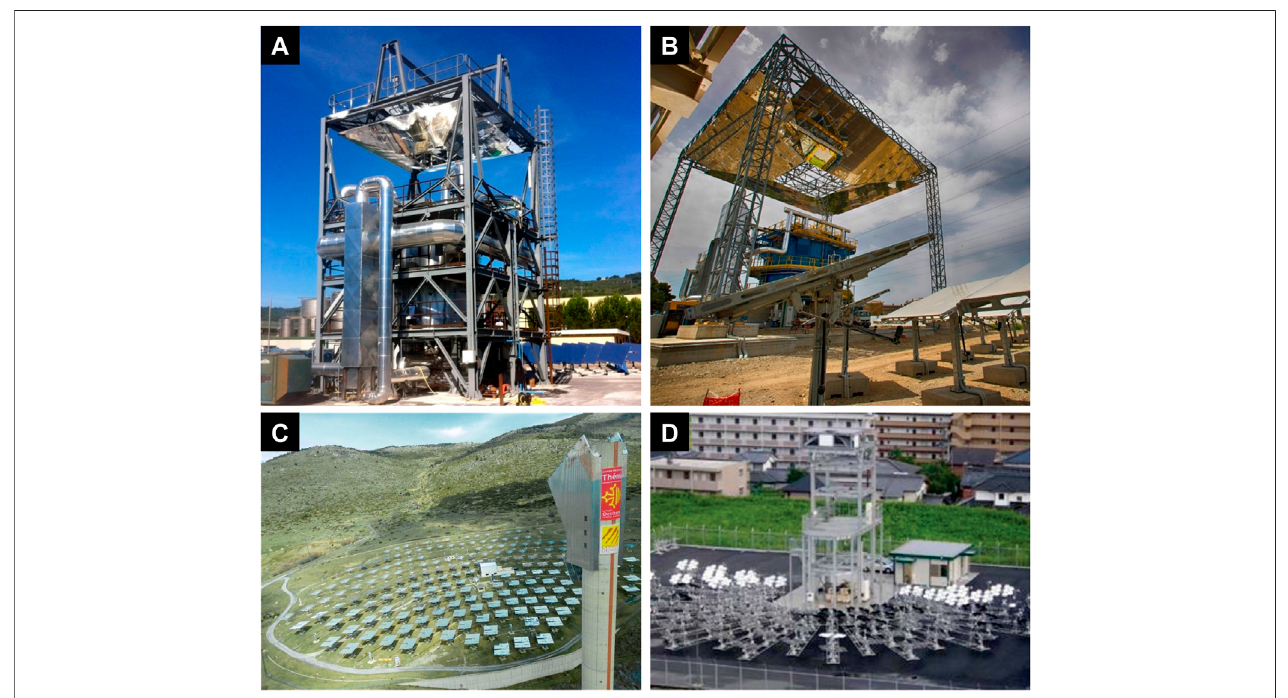
FIGURE9| Photographsof fl uidizedbed installationsforCSP with energy storage. (A) Indirectly irradiated STEM ® Solar Thermo-ElectricMagaldi(Magaldi,2020); (B) Directly irradiated STEM ® SolarThermo-Electric Magaldi (Magaldi,2020); (C) Themis solartowerto be revamped according to the fl uidized particle-in-tube concept (reprinted from Ferriere et al. (2019) with the permission of AIP Publishing); (D) Window-type internally circulating fl uidized bed receiver at Miyazaki (reprinted from Kodama et al. (2017b) with the permission of AIP Publishing).